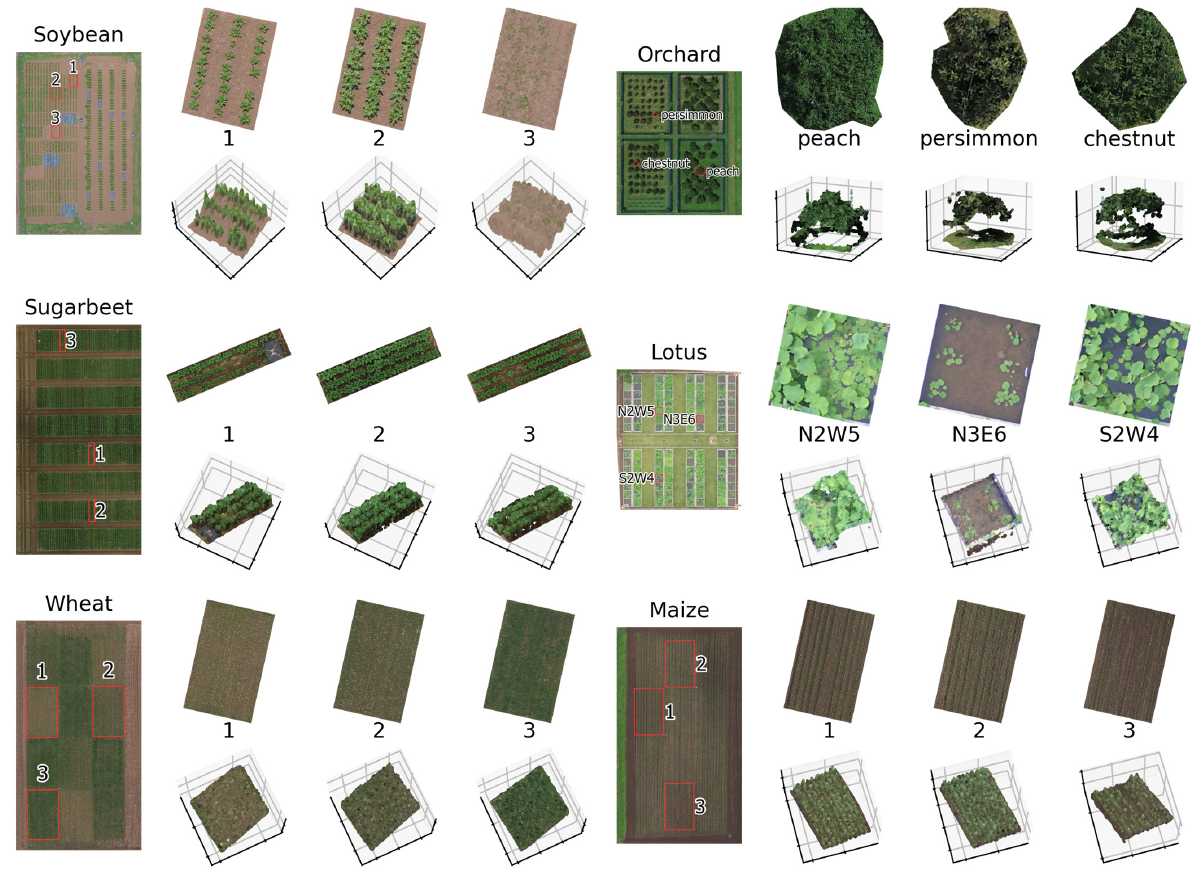
Figure 3. Cropping results for three randomly chosen ROIs of six fields representing different cultivars or treatments. The digital orthomosaic (DOM) and the point cloud (PCD) used in this figure are from the outputs of Metashape.